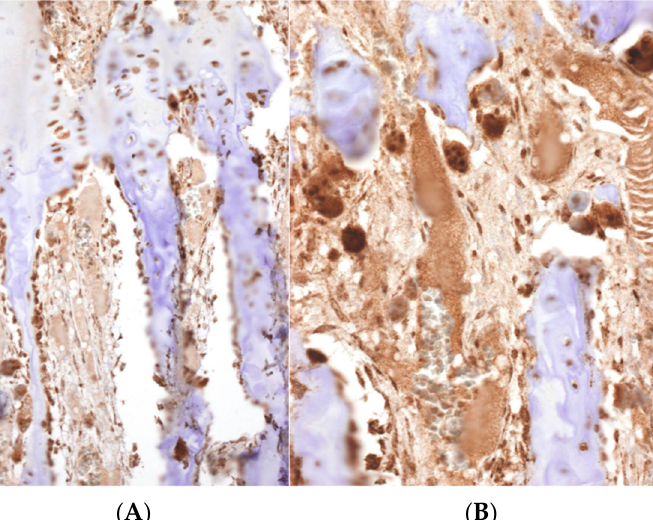
Figure 4. A strong immunoreactivity against VEGF can be observed in the osteoclasts and osteoblasts in the physis. A high density of vessels can be distinguished (Immunohistochemistry, ( A ) ×100, ( B ) ×200).